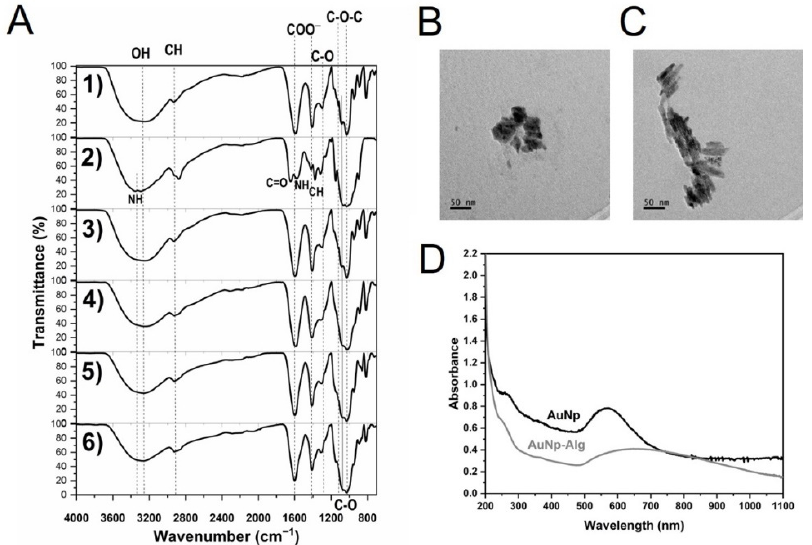
Figure 4. ( A ) FTIR-ATR spectra of: sodium alginate (1), chitosan (2) and alginate/chitosan scaffolds before (3) and after crosslinking (4, Method 3) and with incorporation of gold (5) or gold plus sodium alginate (6) nanoparticles. Vertical dotted and continuous lines are presented as eye guides. Representative electromicrographs of ( B ) AuNp and ( C ) AuNp+Alg obtained by TEM. ( D ) Gold nanoparticles plasmon.